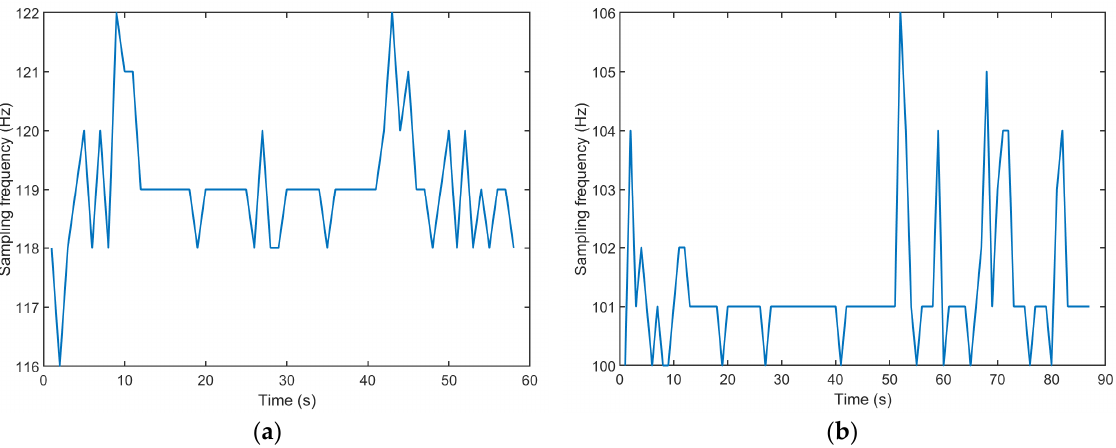
Figure 2. An example of sampling frequency variability in measurements on ( a ) Arduino-based devices with IMU sensors and ( b ) smartphones with IMU sensors.